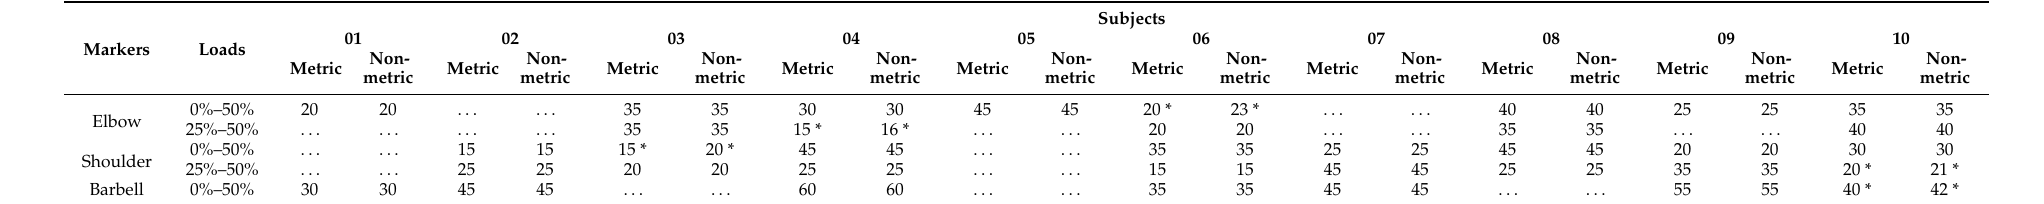
Table 2. Minimum number of states necessary for HMM recognition of differences in the execution of biceps-curl with different loads, and with and without metric of